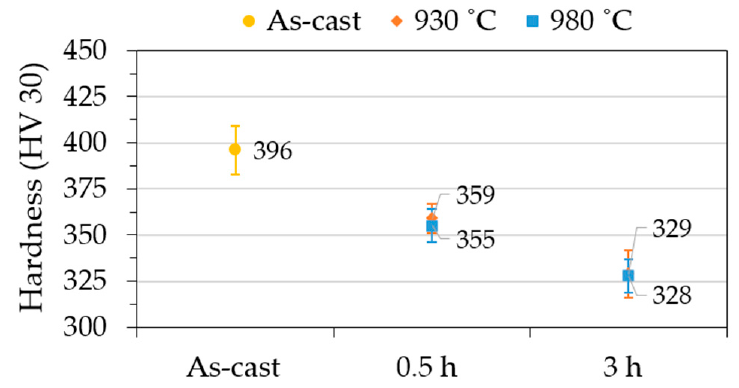
Figure 7. Effect of the solution heat treatment on the hardness of the NiSi3B2 alloy.